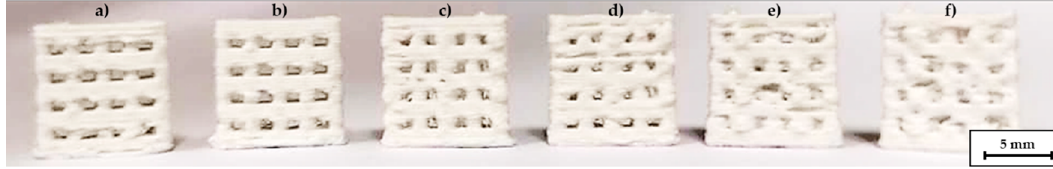
Figure 4. C2 based scaffolds, printed with different temperatures, nozzle diameter 0.4 mm, ( a ) 190 °C, ( b ) 195 °C, ( c ) 200 °C, ( d ) 205 °C, ( e ) 210 °C, ( f ) 215 °C.